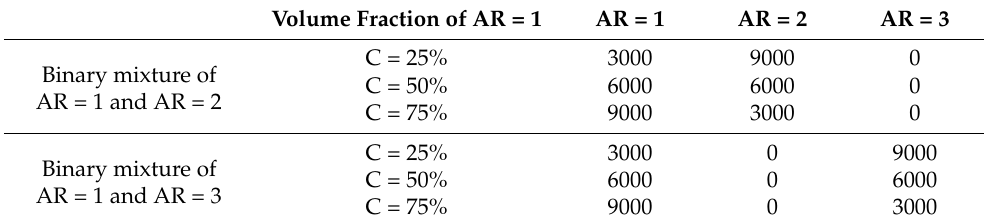
Table 3. Composition of binary mixtures of cylindrical